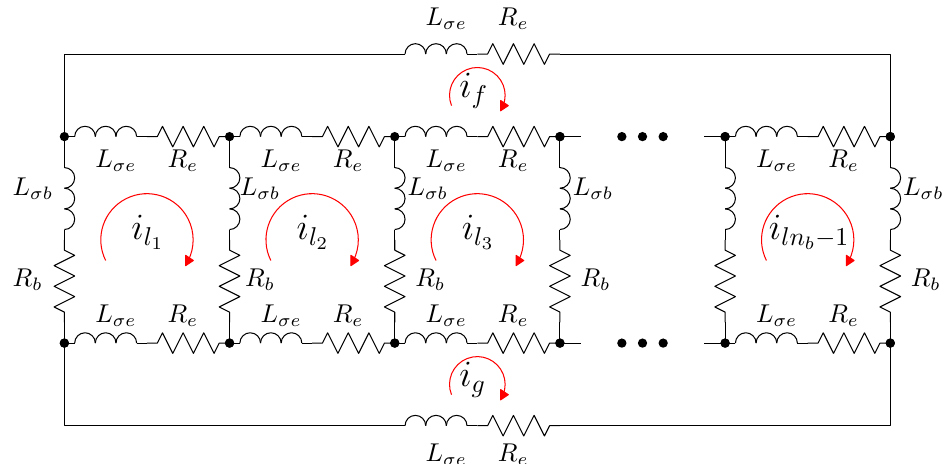
Figure 6. Rotor loops in a squirrel cage rotor of n b bars. There are n b − 1 rotor loops, formed by two consecutive bars, coupled to each other and to the stator windings through their mutual inductances (not displayed in this schema). Besides, there are two end ring loops, which do not couple with any other windings through mutual